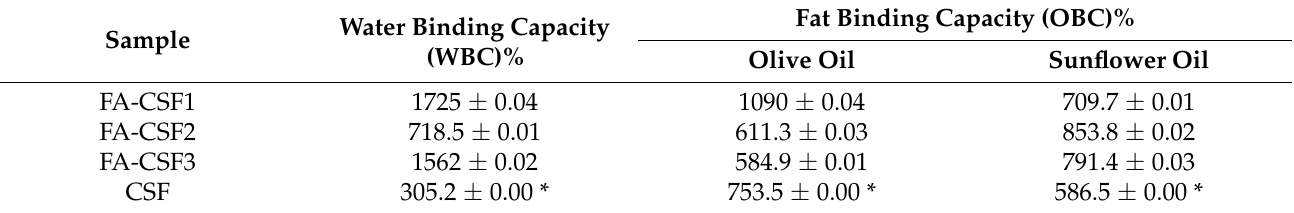
Table 1. The water binding capacity (WBC)%, and oil binding capacity (OBC)% of chitosan-based films loaded with fly